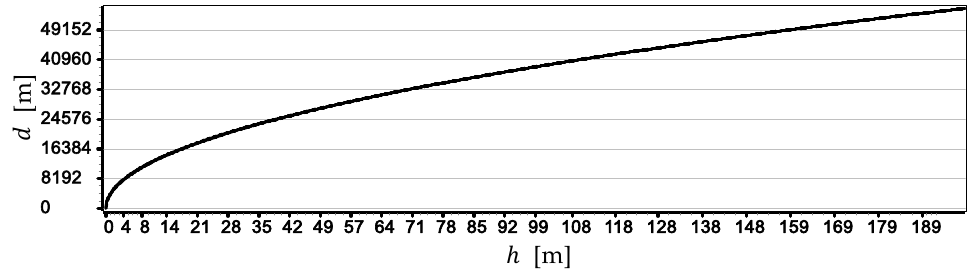
Figure 7. Distance to the horizon line 𝑑 as a function of the height of the camera a.s.l ℎ.